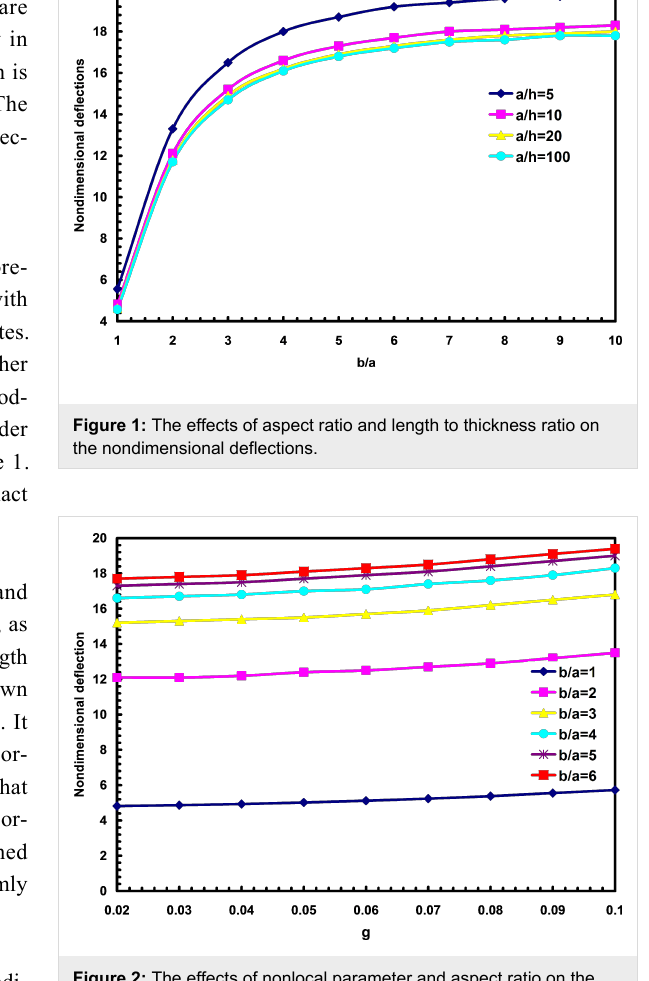
Figure 2: The effects of nonlocal parameter and aspect ratio on the nondimensional